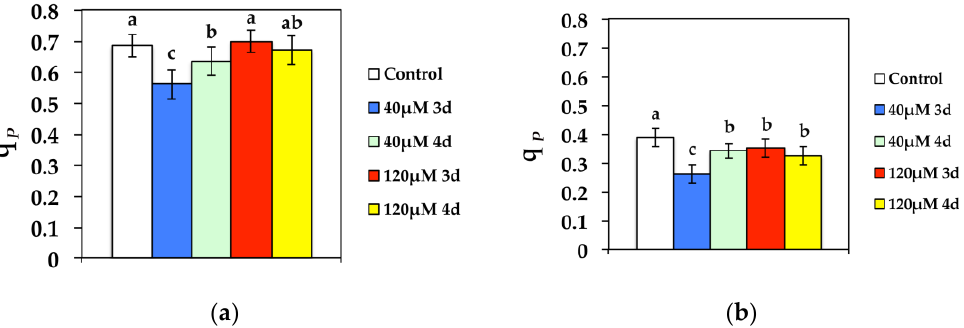
Figure 7. Changes in the photochemical fluorescence quenching, that is the relative reduction state of